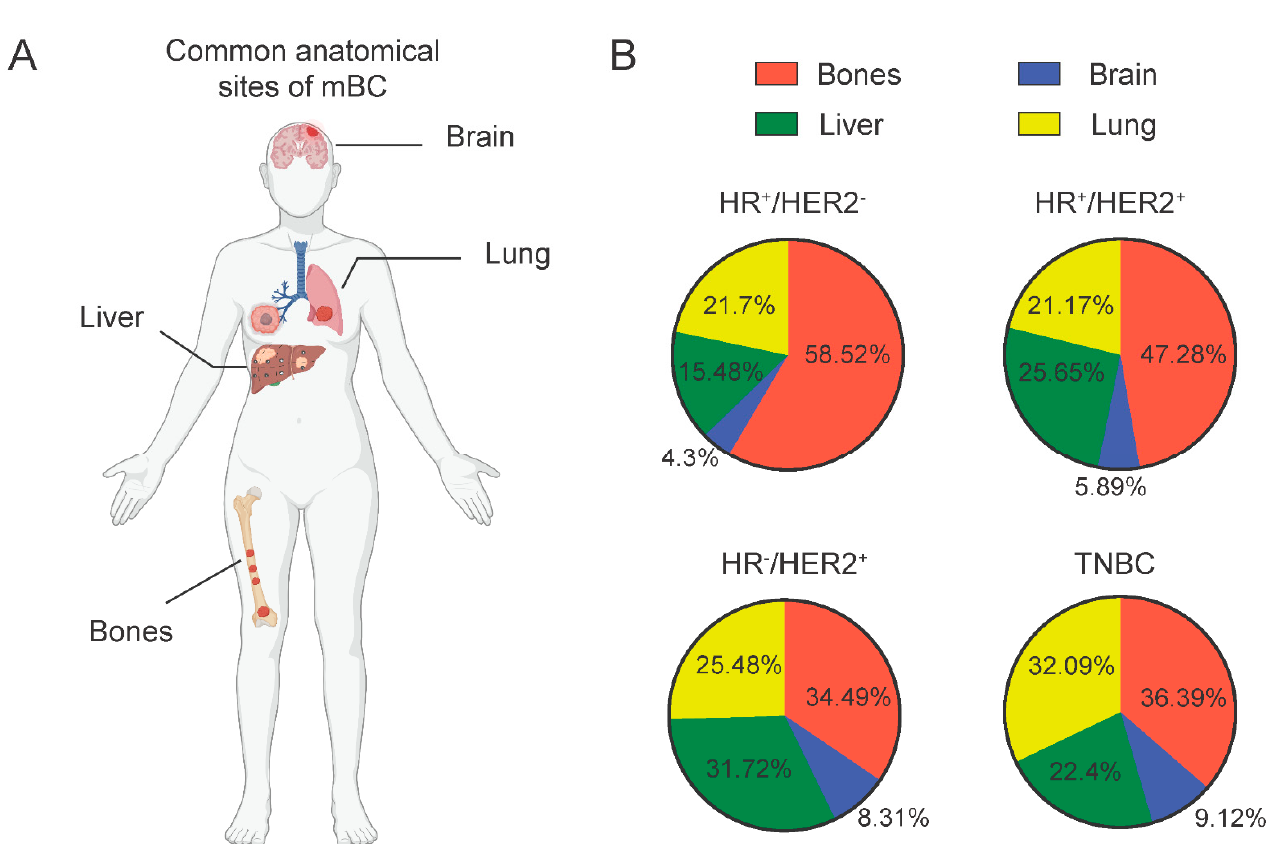
Table 1. Prognostic and Predictive factors for metastatic Breast Cancer.